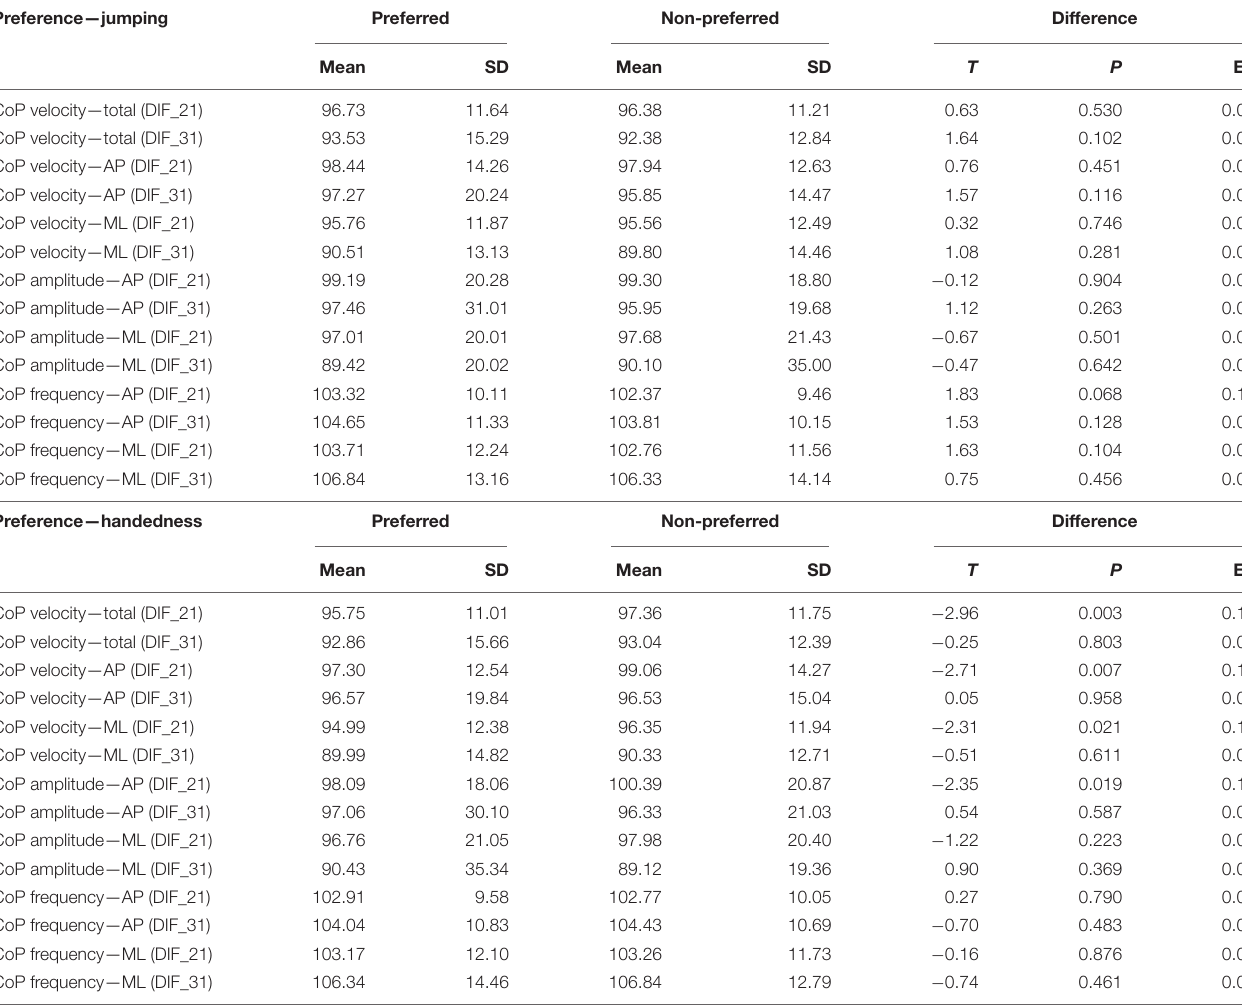
TABLE 3 | Transient characteristics of body sway in the preferred and non-preferred legs.